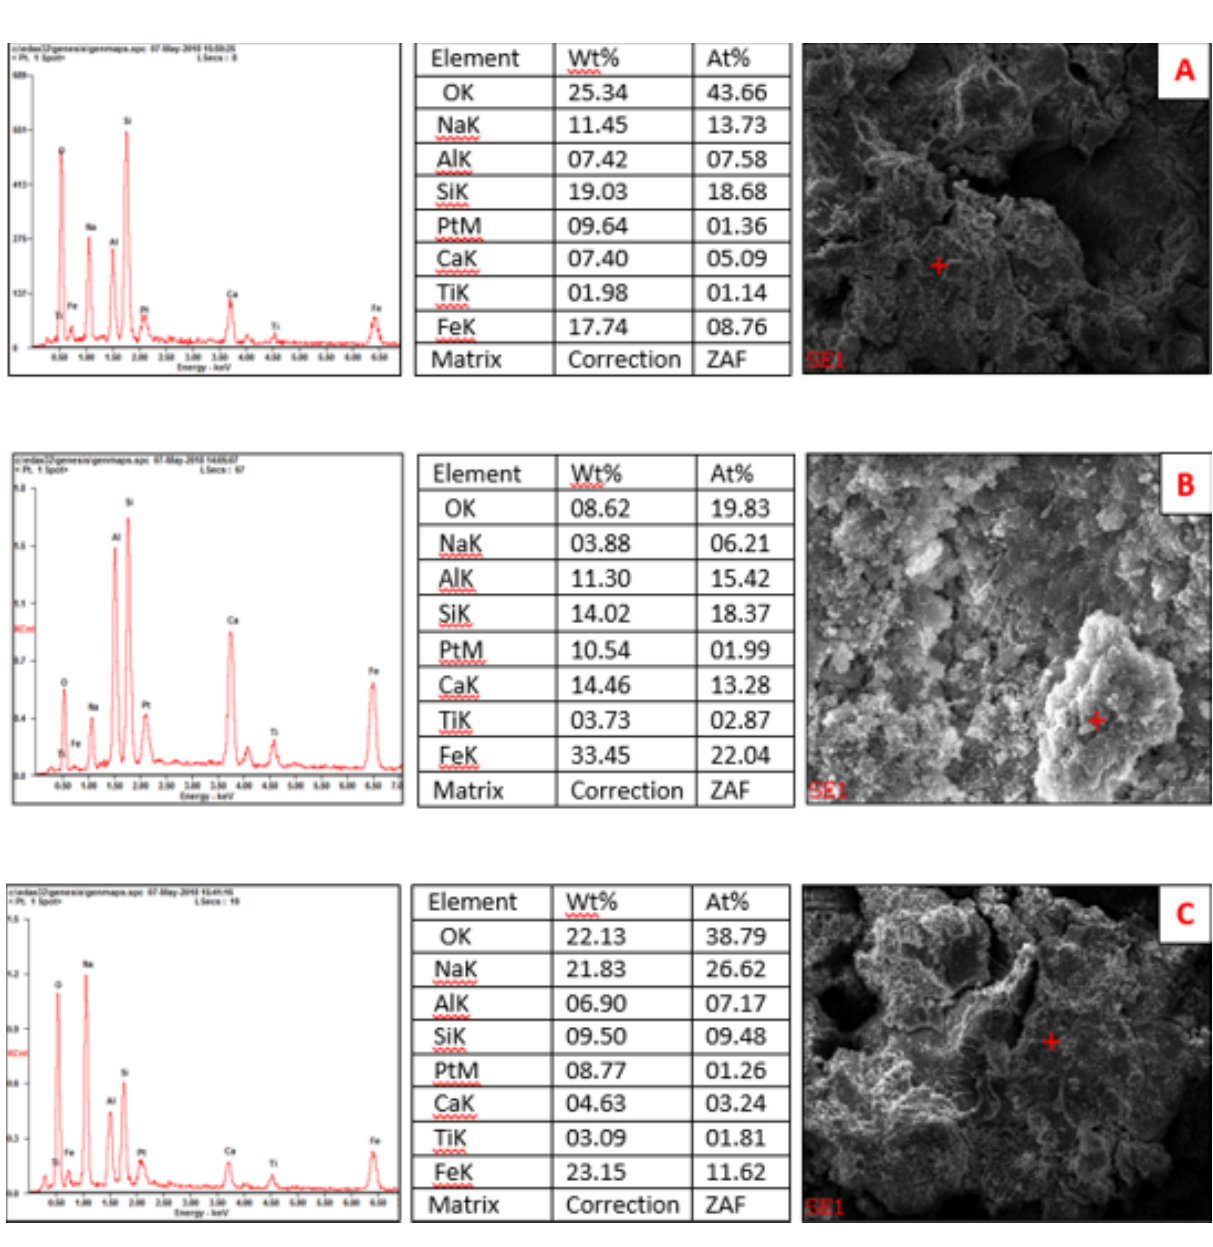
Figure 16: SEM-EDX images of S4.4, N0.4 and N1.0 at 28 days